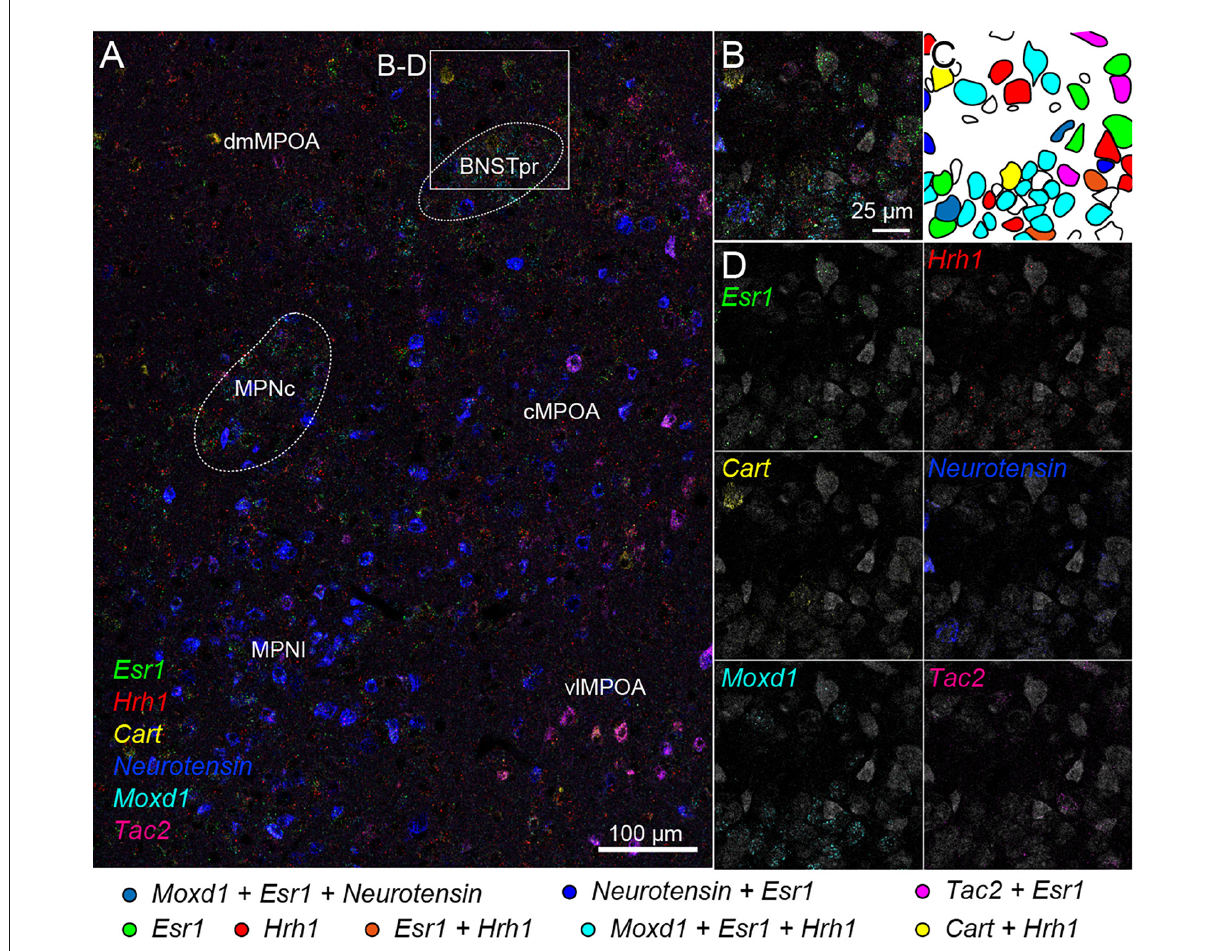
FIGURE7 Cell typing using two rounds of ISH combined with Nissl staining. Two-round ISH visualized Esr1 , Hrh1 , Cart , neurotensin , Moxd1 , and Tac2 mRNAs. (A) Wide-field merged image of the medial preoptic area (MPOA). The rectangle indicates the region shown in (B–D) . Scale bar: 100 µ m. (B) Merged image of six different mRNAs and fluorescent Nissl staining (gray). (C) Drawing of each cell position and cell type. Colors indicate different cell types shown at the bottom. (D) Separate images of each mRNA and fluorescent Nissl staining. Scale bar: 25 µ m. BNSTpr, bed nucleus of the stria terminalis, principal nucleus; cMPOA, central part of MPOA; dmMPOA, dorsomedial part of MPOA; MPNc, medial preoptic nucleus (MPN), core part; MPNl, MPN, lateral part; vlMPOA, ventrolateral